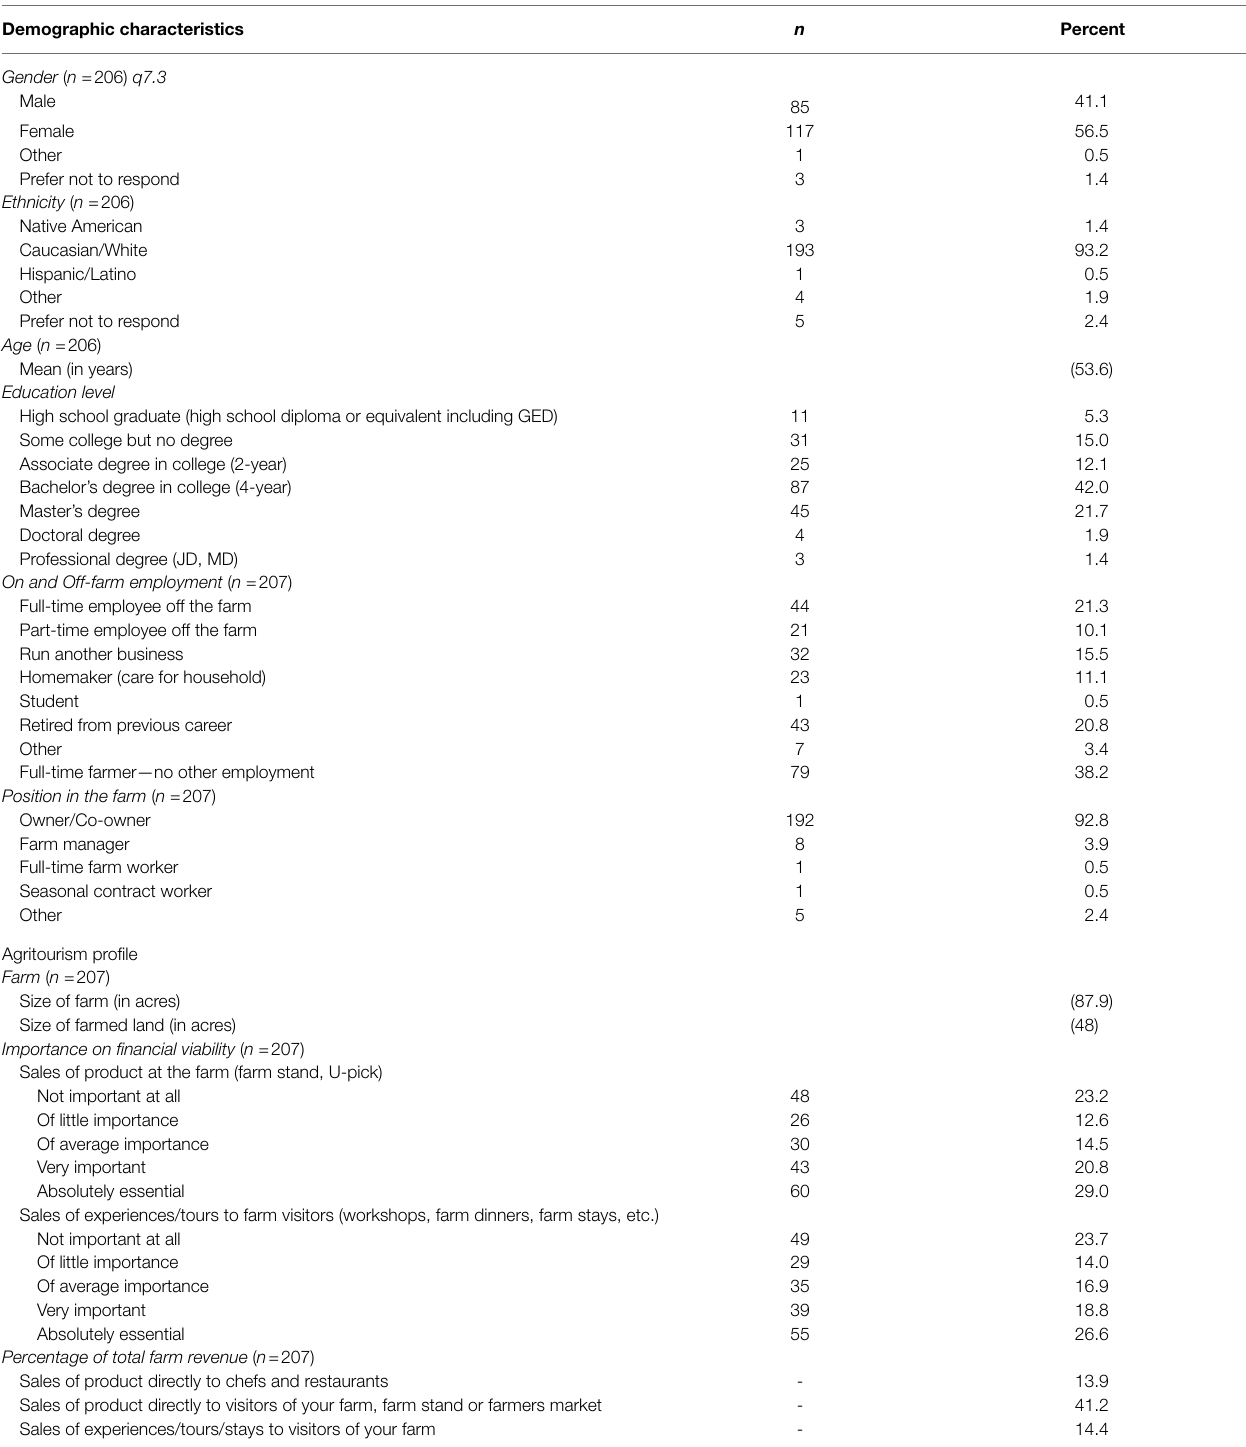
TABLE 1 | Farmers demographic and agritourism profile. Demographic